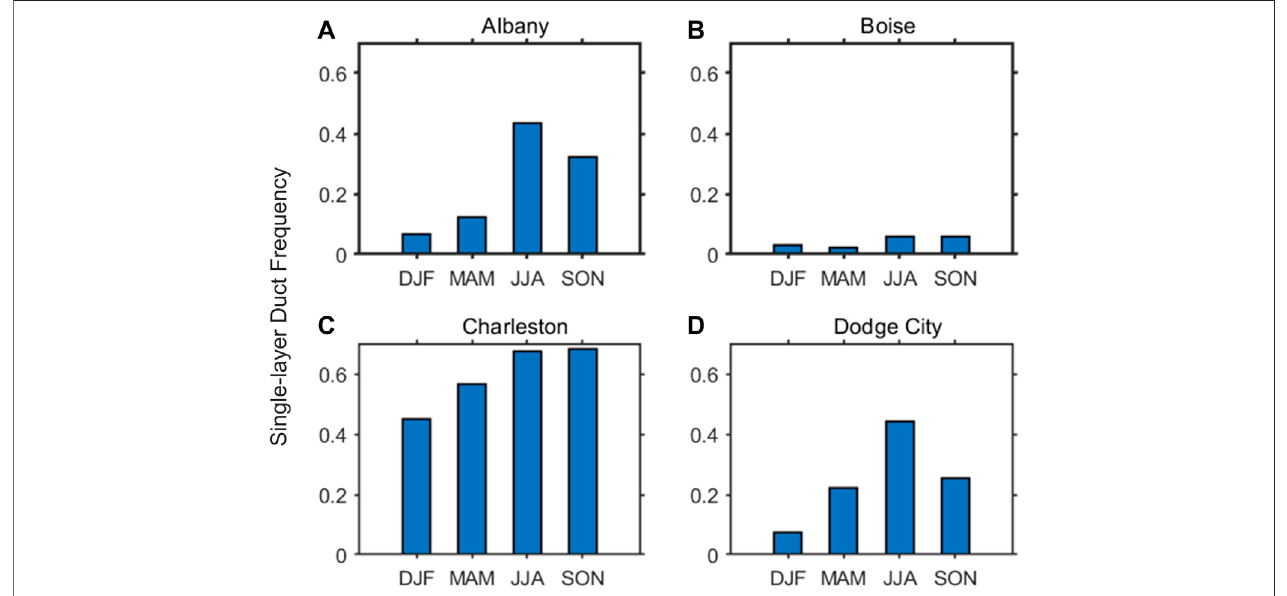
FIGURE 6 | The seasonal variation of the multiple-layer duct frequency over the four stations. (A – D) Albany, Boise, Charleston, and Dodge City.